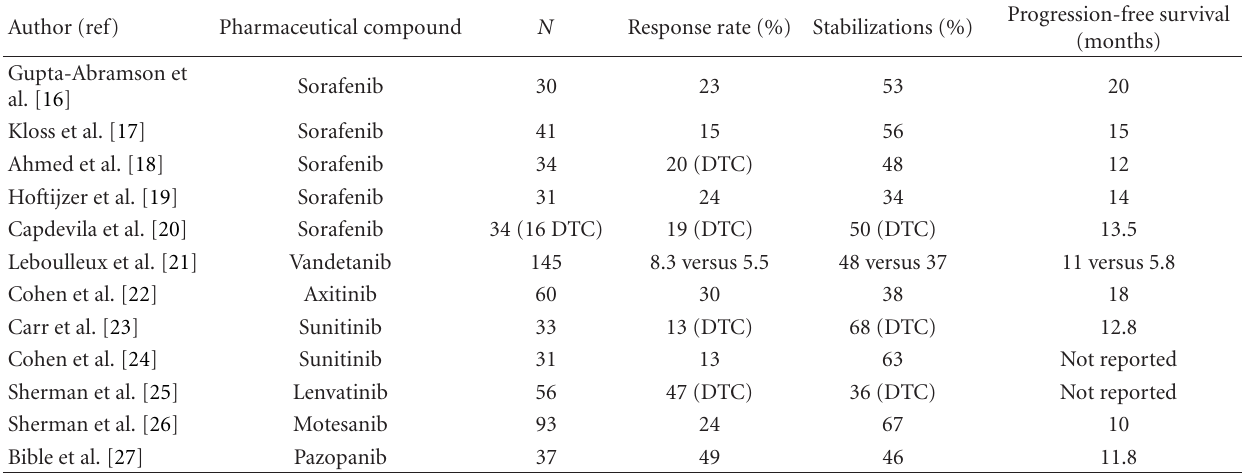
Table 2: Clinical data from studies with the main agents in clinical development in di ff erentiated thyroid